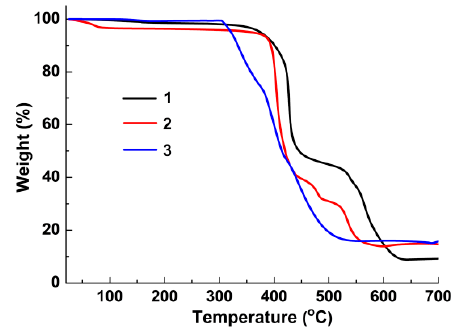
Figure 4. Thermal gravimetric analysis (TGA) curves of complexes 1 – 3 .